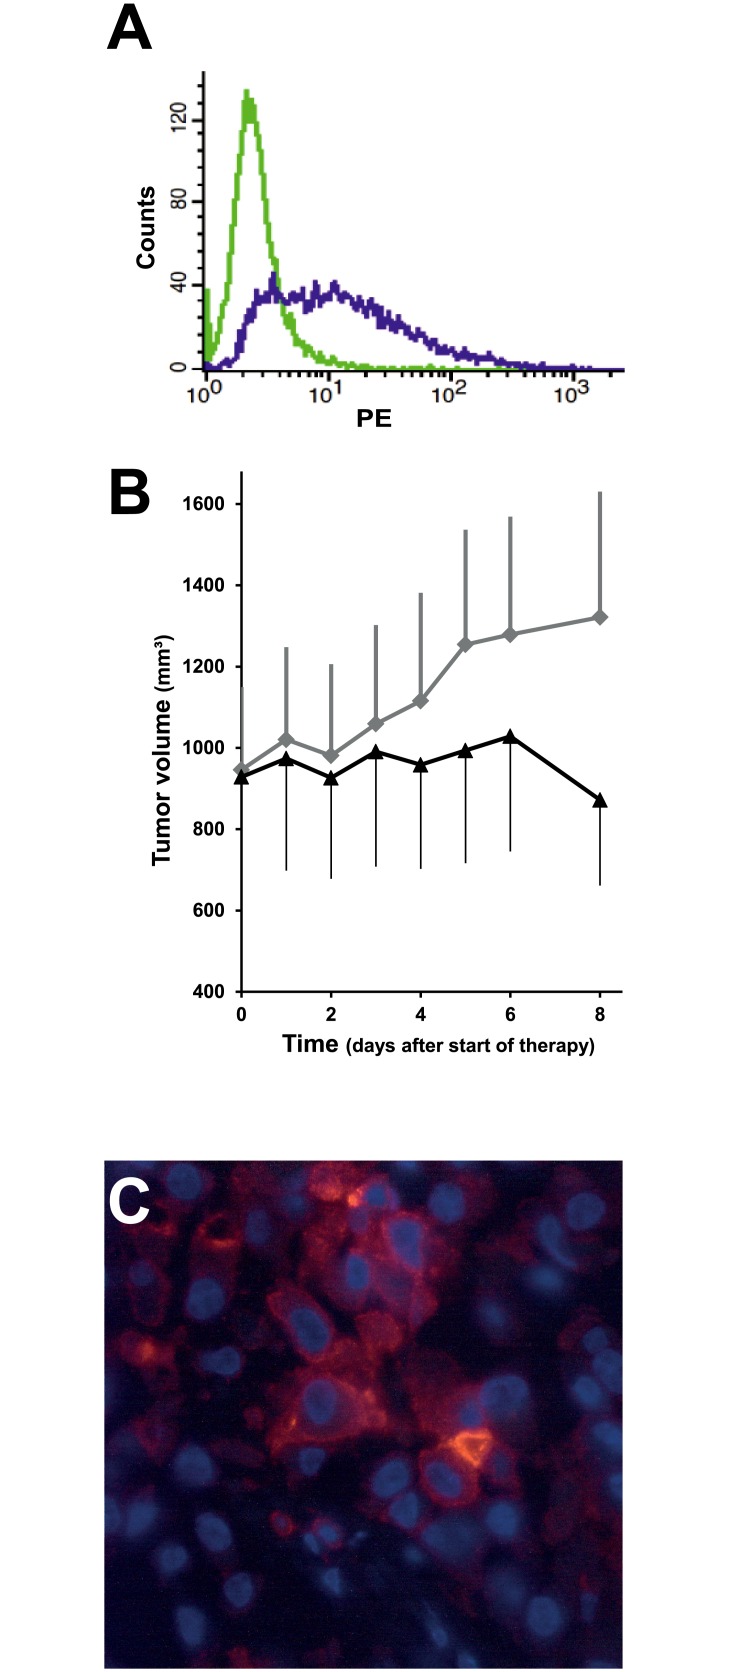
In vivo therapeutic activity of systemic tTF-NGR against CD13+ A549 tumor xenografts.To investigate CD13 expression flow cytometry was performed with a monoclonal PE-labeled anti-CD13 antibody. CD13 expression was found in 47% of the A549 lung cancer cells (green, control; purple, CD13) (Fig. 3A). Following treatment with tTF-NGR (1 mg tTF-NGR/kg x4 (arrows); i.v.; n = 4 CD-1 nude mice) tumor growth of subcutaneous A549 xenotransplants was reduced as compared to the saline control group (n = 6) CD-1 nude mice (Fig. 3B). The CD13 expression in subcutaneous A549 xenotransplant is demonstrated by immunofluorescence; since the antibodies used for CD13 and CD31 staining are species-specific for human CD13 and CD31, vascular and perivascular staining were not assayed in the xenografts (Fig. 3C).